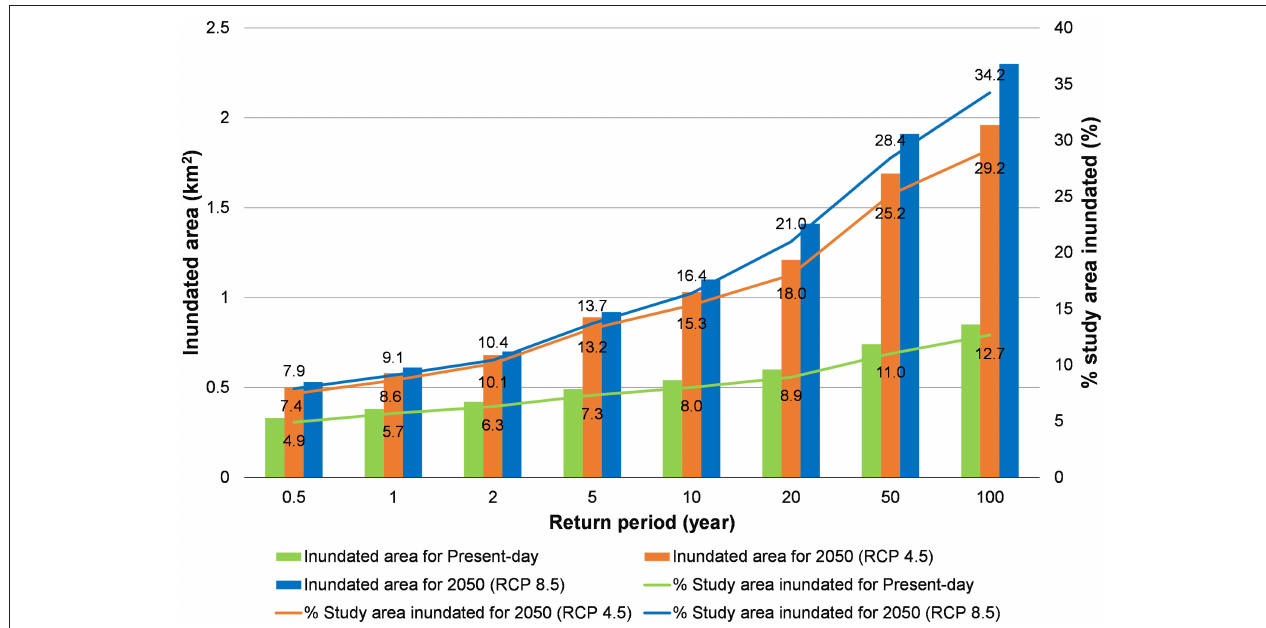
FIGURE 12 | The inundated area and percentage of the flooded area relative to total study area (also indicated by numerics along the solid lines in this figure) corresponding to each return period of water level (without land